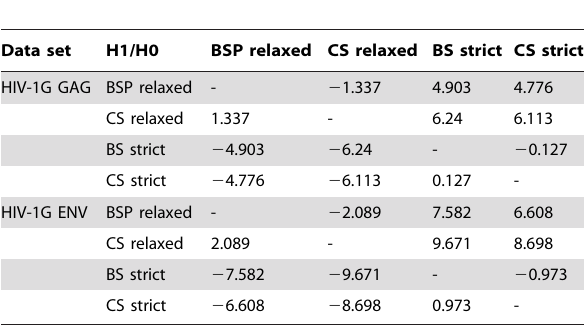
Table 2. Natural logarithm Bayes factors between different